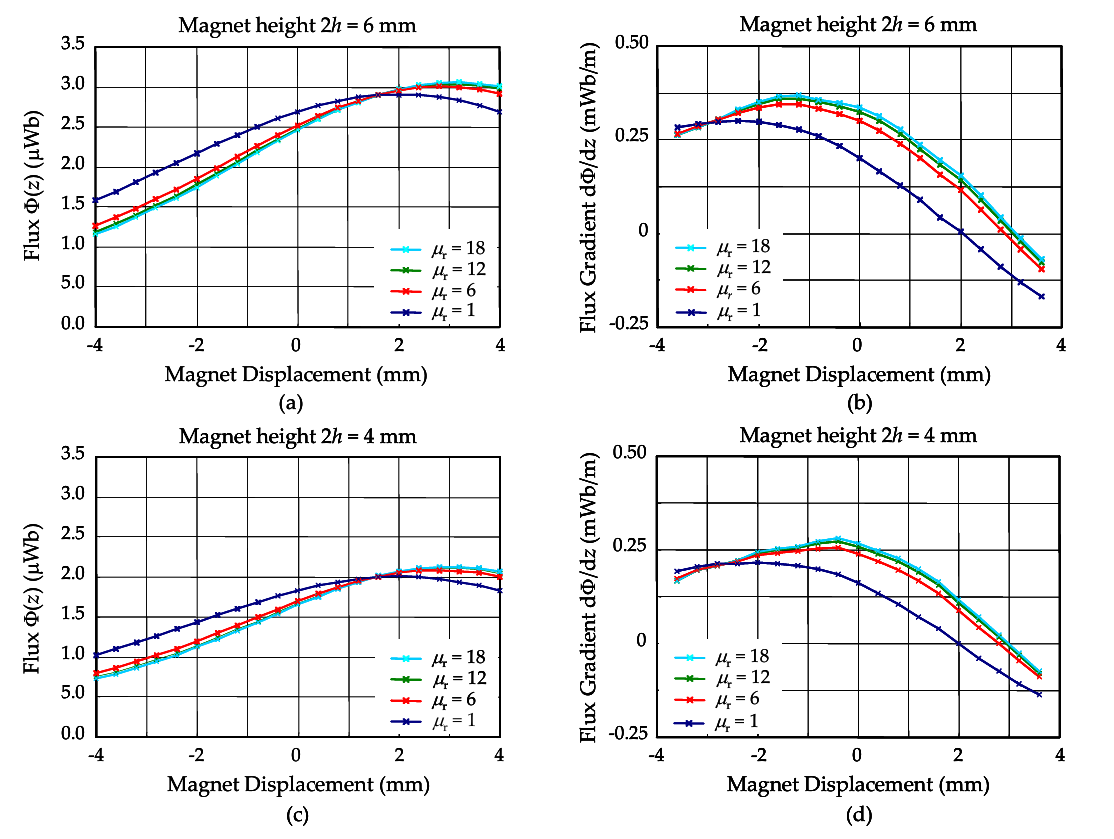
Figure 4. Magnetic flux and flux gradient obtained from finite-element-method (FEM) calculation for various devices configurations. ( a ) Magnetic flux for 2 h = 6 mm; ( b ) magnetic flux gradient for 2 h = 6 mm; ( c ) magnetic flux for 2 h = 4 mm; ( d ) magnetic flux gradient for 2 h = 4 mm. For devices without